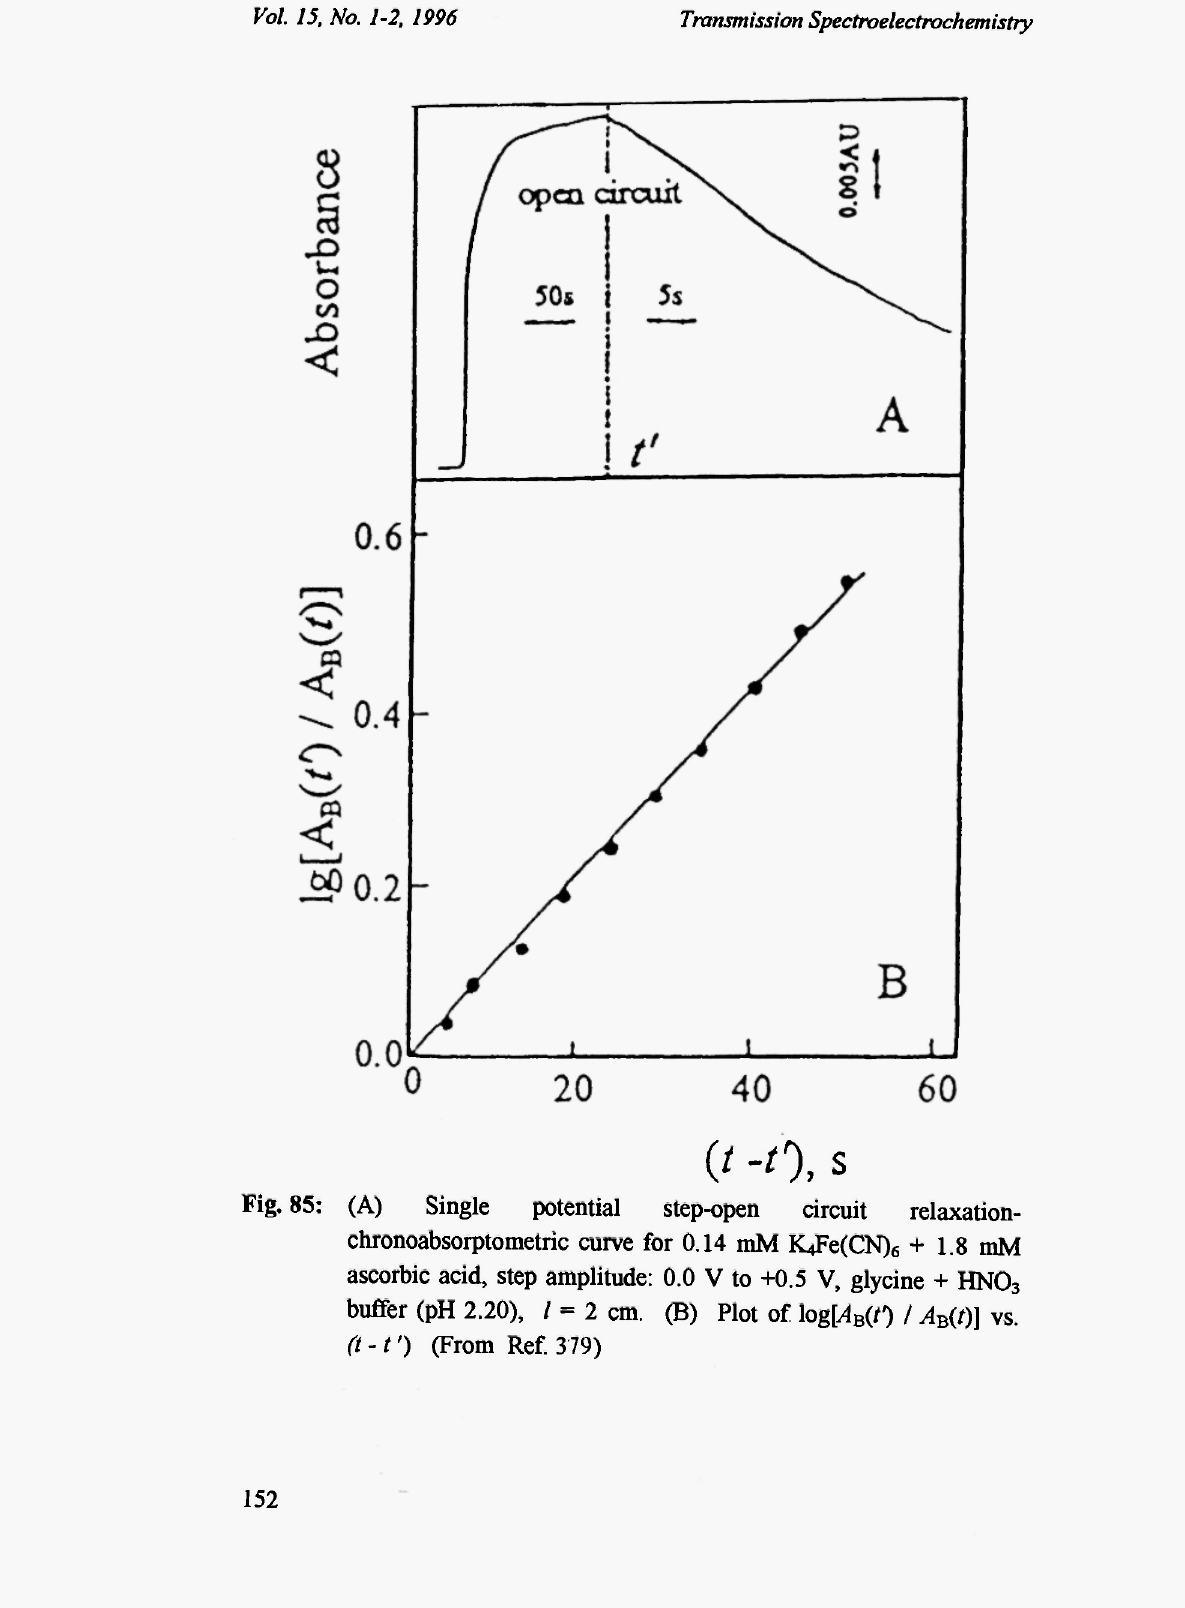
Fig. 85: (A) Single potential step-open circuit relaxation- chronoabsorptometric curve for 0.14 mM K4Fe(CN) ascorbic acid, step amplitude: 0.0 V to +0.5 V, glycine + HN0 buffer (pH 2.20), / = 2 cm. (B) Plot of log[^ ( t - f) (From Ref. 379)